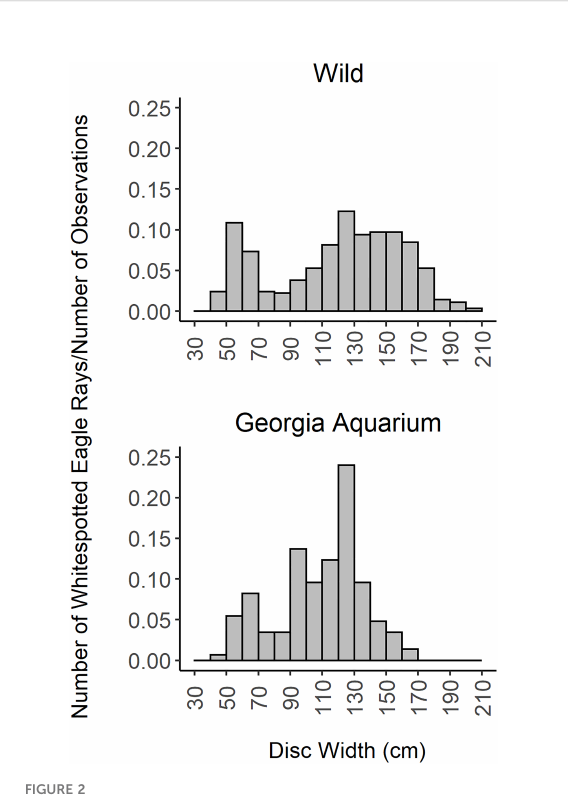
FIGURE 2 Normalized size histogram of wild and aquarium-housed Aetobatus narinari . Wild sample consists of 628 measurements from 589 individuals, with 1-3 measurements per individual. Aquarium sample consists of 146 measurements from 19 individuals, with 5-11 measurements per